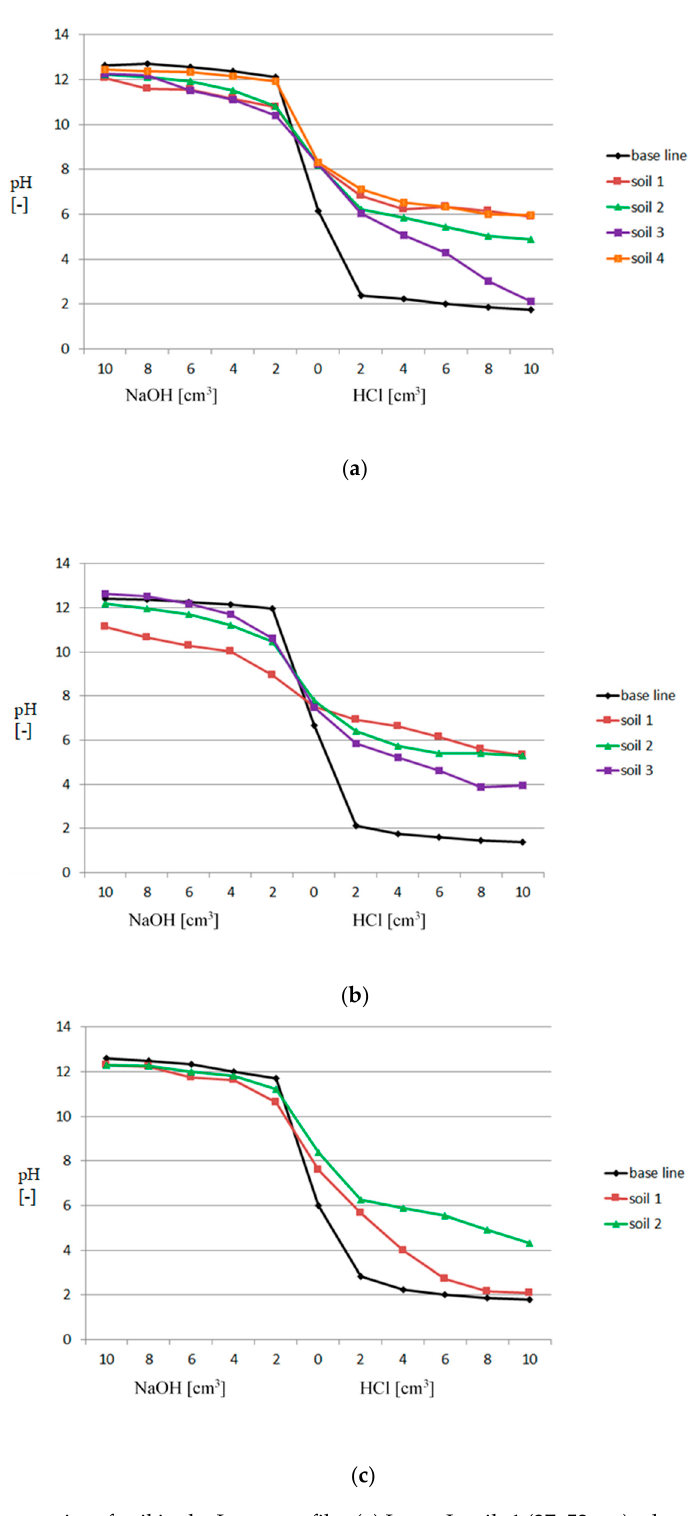
Figure 2. Buffer capacity of soil in the Lgota profiles ( a ) Lgota I, soil: 1 (37–52 cm)—loam with carbonate debris, 2 (130–138 cm) and 3 (138–144 cm)—silty loams, 4 (154–190 cm)—weathered limestone rock debris; ( b ) Lgota II, soil: 1 (7–17 cm) and 2 (17–37 cm)—soil with carbonate debris, 3 (62–72 cm)—dark brown silts; ( c ) Lgota III, soil: 1 (27–37 cm)—sandy loam, 2 (37–40 cm)—fragments of crushed carbonates rock.